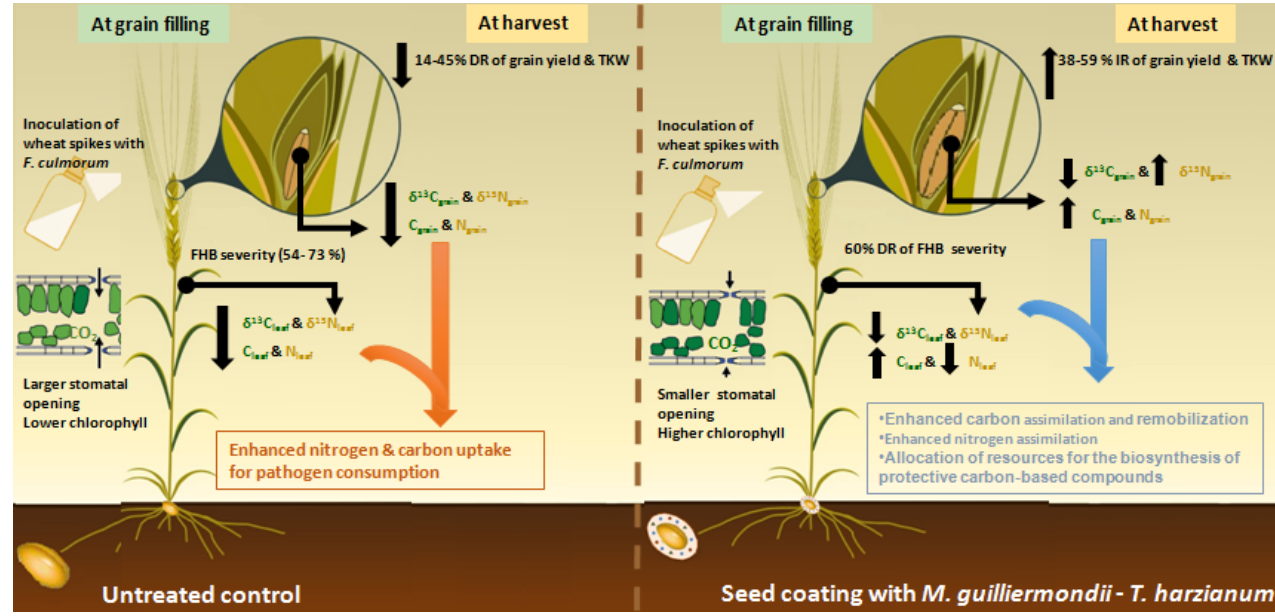
Figure 3. Schematic representation of the impact of FHB disease and the highest yielding treatment M. guilliermondii-T. harzianum on physiological traits, grain yield and N/C metabolism in durum wheat.